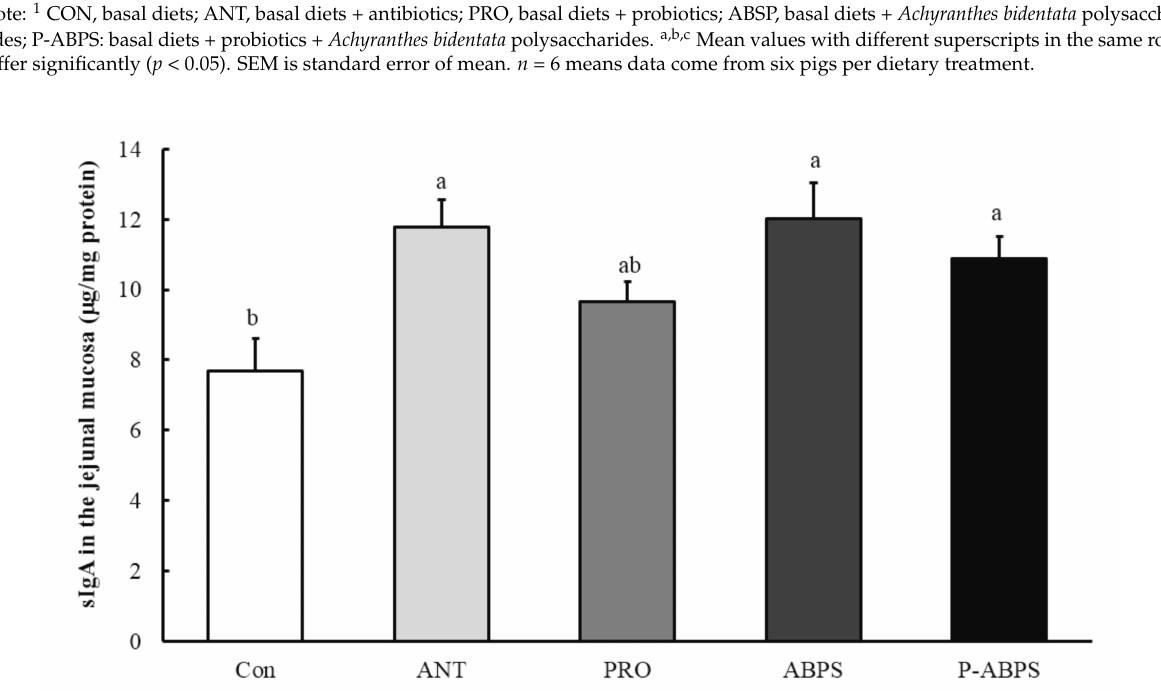
Figure 1. Levels of secreted immunoglobulin A (sIgA) in the jejunal mucosa. CON, basal diets; ANT, basal diets + antibiotics; PRO, basal diets + probiotics; ABSP, basal diets + Achyranthes bidentata polysaccharides; P-ABPS: basal diets + probiotics + Achyranthes bidentata polysaccharides. Different letters (a,b) above the error bars indicated significant differences ( p < 0.05). n = 6 means data come from six pigs per dietary